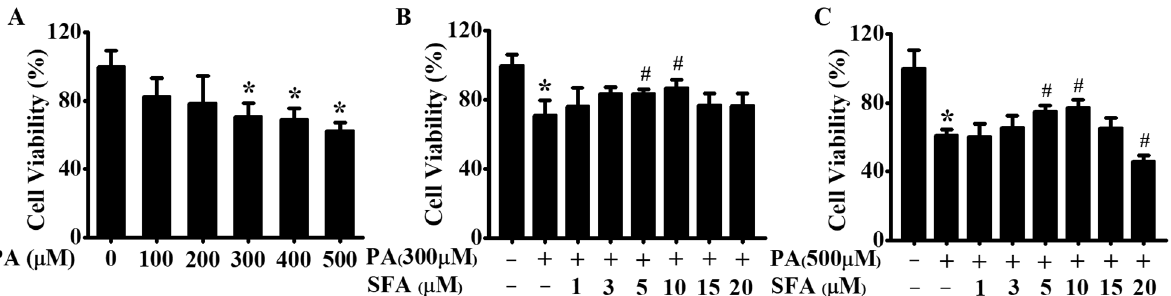
Figure 1. Effects of PA and SFA on cell viability in HepG2 cells: ( A ) cells treated with different concentrations of PA for 24 h. Cells treated with different concentrations of SFA in the presence of 300 µ M of PA ( B ) or 500 µ M of PA ( C ) for 24 h. Cell viability presented as the percentage of viable cells relative to that in control group. All values are expressed as means ± SD from three independent determinations, * p < 0.05 vs. control cells; # p < 0.05 vs. only PA-stressed HepG2 cells. PA, palmitic acid; SFA, sulforaphane.